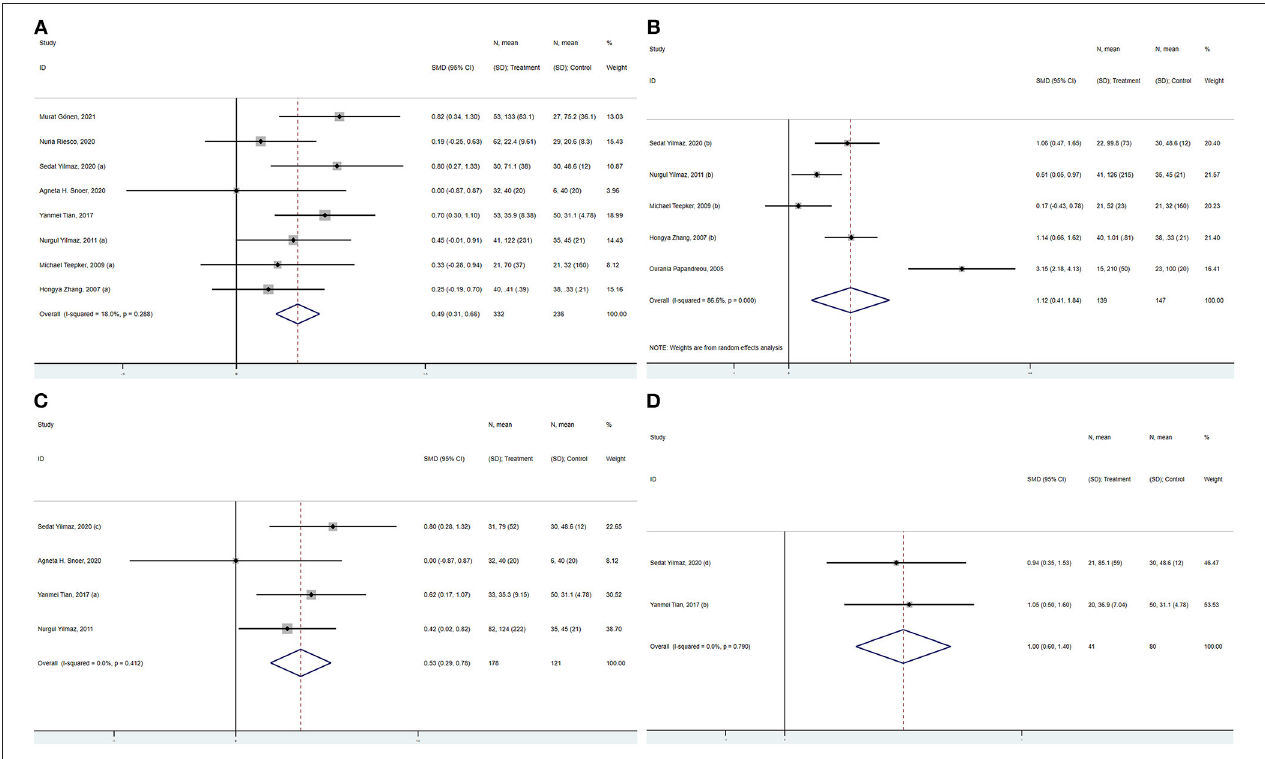
FIGURE 3 | Forest plot for the association between S100B levels and migraine (A) in the interictal period, (B) in the ictal period, (C) without aura, and (D) with aura. SMD, standardized mean difference; CI, confidence interval.